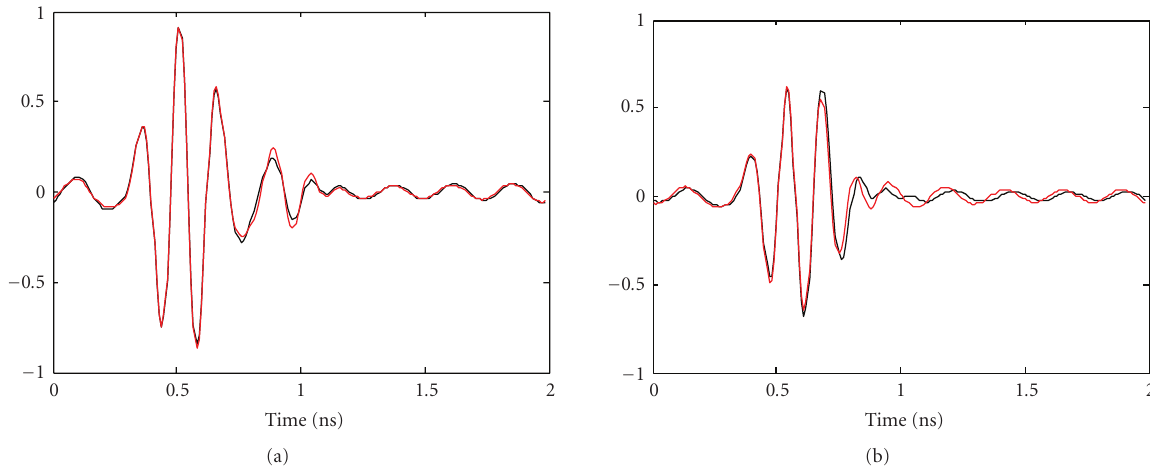
Figure 17: Expected radiated waveform (black line), SC approximation (red line) at (a) ϕ = 0 ◦ and θ = 90 ◦ , (b) θ = 30 ◦ .